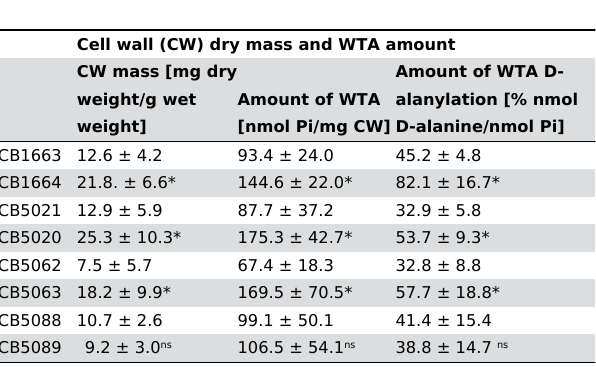
Table 2. WTA and WTA D-alanylation in the DAP-S/ DAP-R strain